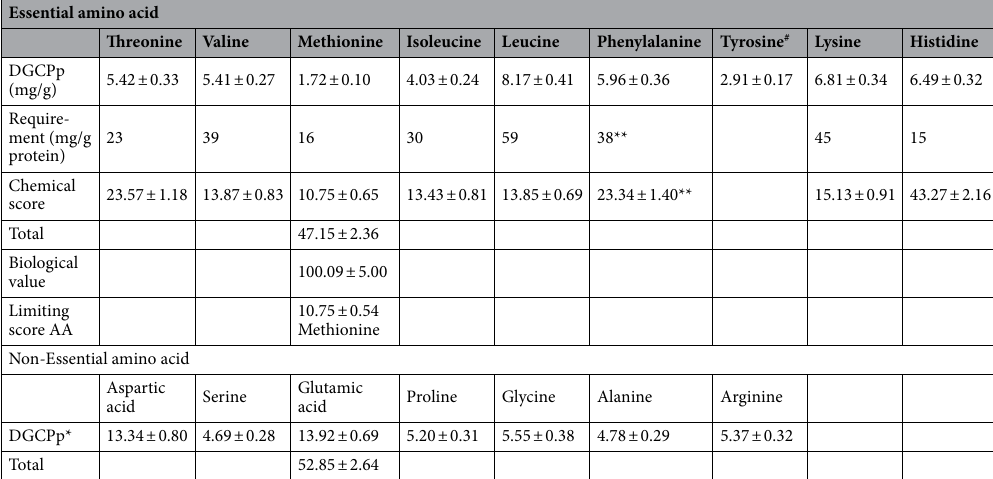
Table 3. Amino acids profile of DGCPp compared with the requirement according to WHO/FAO/UNU. *From WHO/FAO/UNU 30 , **Phenylalanine + Tyrosine. # Tyrosine is a non-essential amino acid, but it was mentioned within the essential amino acid for comparison with the permissible recommendations according to WHO/FAO/UNU 30 where the aromatic amino acids are mentioned together (phenylalanine and tyrosine).